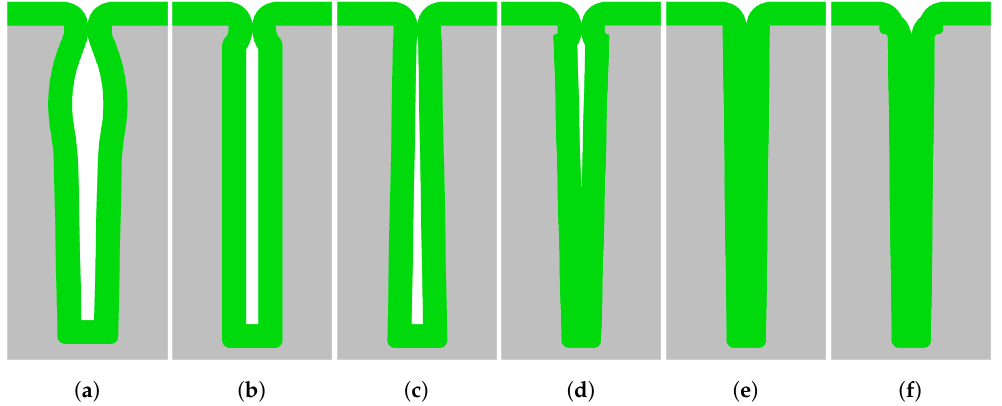
Figure 3. A schematic overview of refilled trenches with and without the trench entrance effect and various sidewall irregularities. In ( a ), a combination of the entrance effect with the bottling effect; in ( b ), a combination of the entrance effect with a 90° directional profile in the trench; in ( c ), a negative tapered (re-entrant) profile; in ( d ), a combination of the entrance effect with a positively tapered profile; in ( e ), an ideally positively tapered profile without any entrance effect; and in ( f ), a positively tapered profile with increased widening at the top for an optimal conformal refill. Here, ( a – d ) result in keyhole formation after refill. In this image, the colours correspond to the following materials: silicon and refill material, such as Si x N y